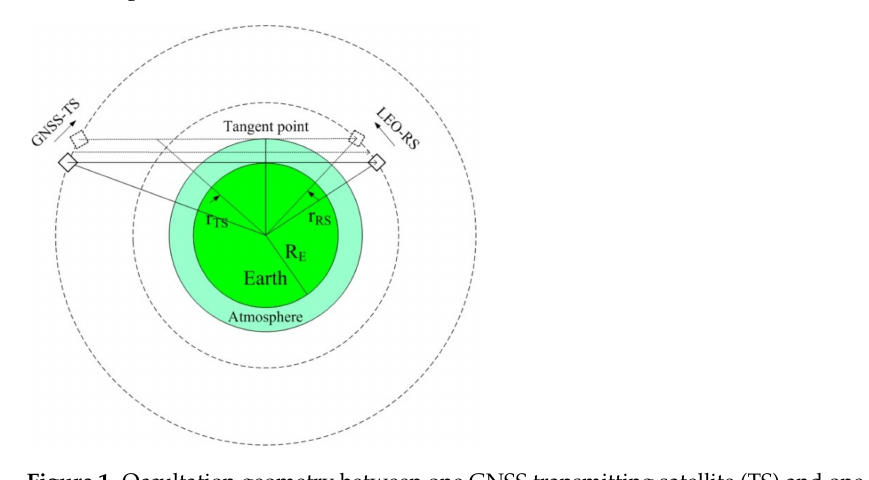
Figure 1. Occultation geometry between one GNSS transmitting satellite (TS) and one LEO receiving satellite